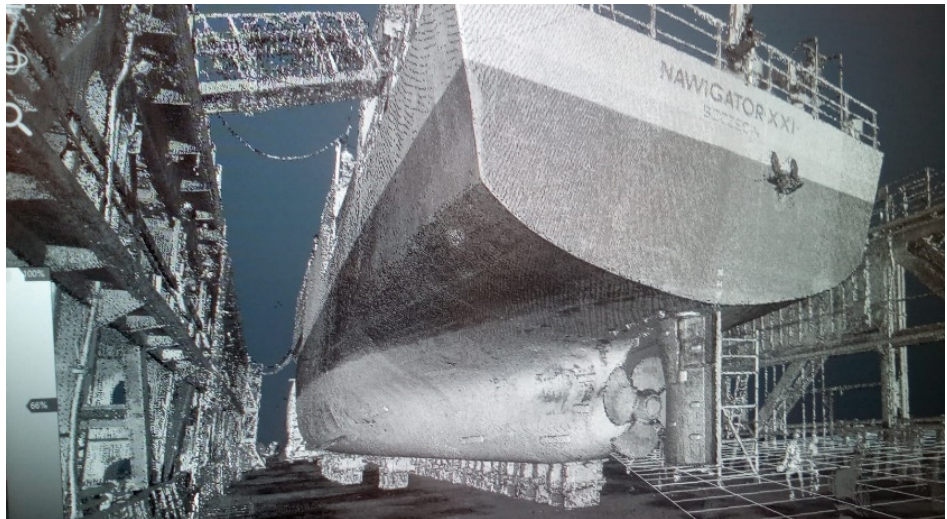
Figure 8. Terrestrial Laser Scanning (TLS) point cloud of Navigator XXI vessel for field research validation.